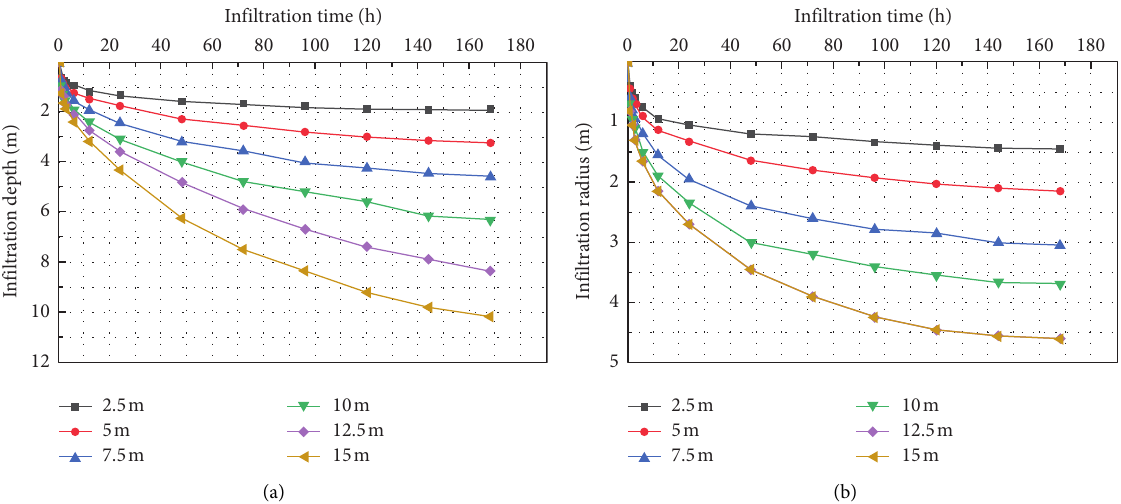
Figure 8: (a) Change curve of infiltration depth with immersion time. (b) Infiltration radius change curve with immersion time.